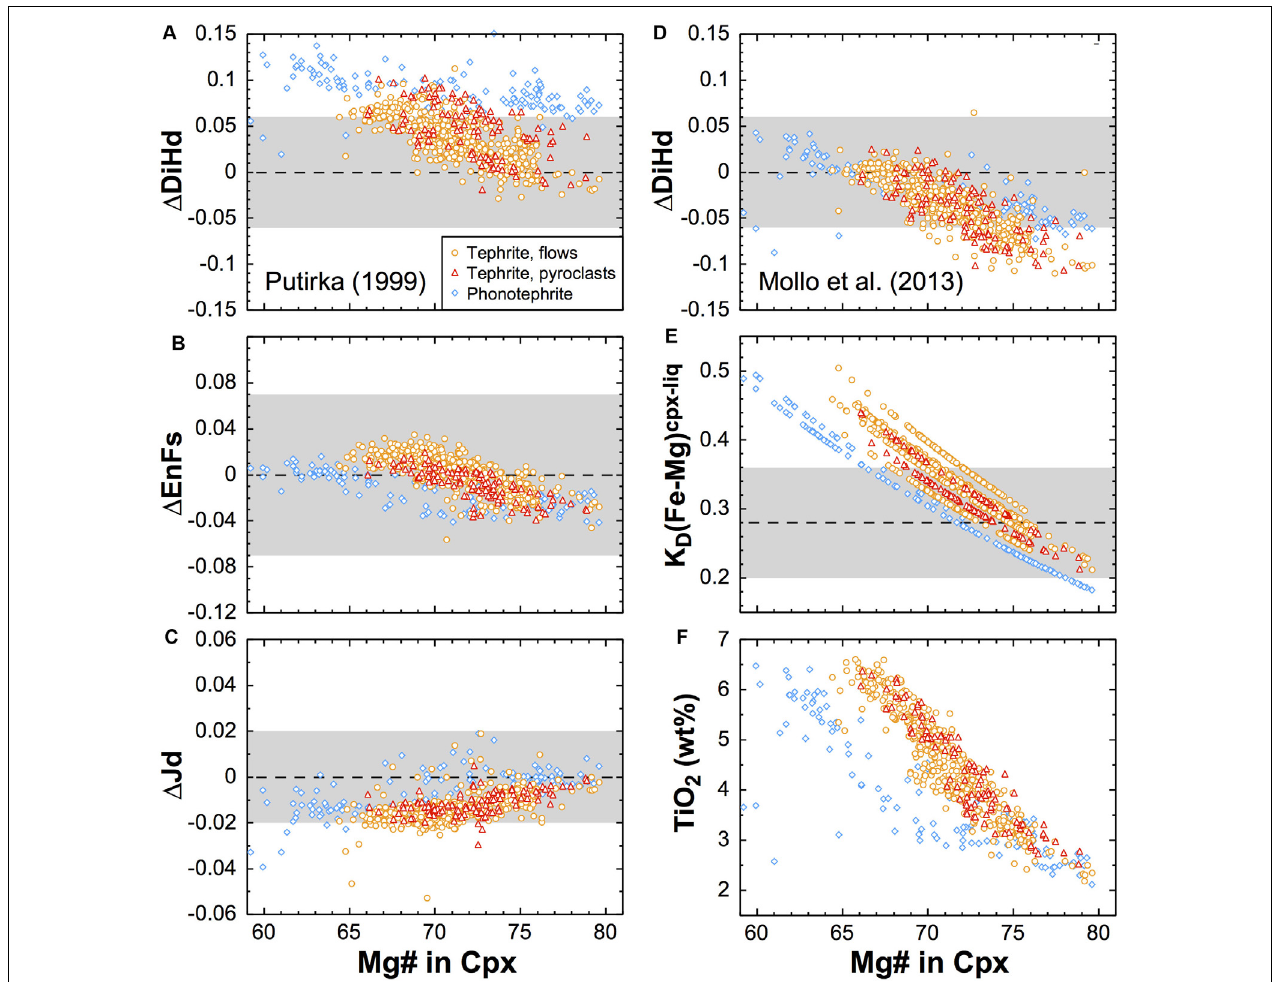
FIGURE 9 | Compositional range and equilibrium criteria for the rims of clinopyroxene phenocrysts in tephrites (590 analyses) and phonotephrites (diamonds; 125 analyses) from the 2014–2015 eruption. The diagrams present clinopyroxene Mg# versus (A) (cid:49) DiHd; (B) (cid:49) EnFs; (C) (cid:49) Jd; (D) (cid:49) DiHd after Mollo et al. (2013); (E) measured K D (Fe-Mg) cpx − liq using groundmass compositions; and (F) TiO 2 in clinopyroxene. In (A–C) the delta notations indicate the difference between predicted and measured clinopyroxene components after Putirka (1999). For (cid:49) EnFs, the more recent calibration of Mollo et al. (2013) yields a similar distribution but is shifted by +0.010 to +0.015. Dashed lines show the equilibrium values for clinopyroxene components and the global mean for K D (Fe-Mg) cpx − liq ; gray fields encompass ± 1 SEE of the model error for clinopyroxene components, and ± 1 standard deviation for the mean K D (Fe-Mg) cpx − liq (Putirka, 2008). For tephrites the diagrams discriminate between crystals in rapidly cooled pyroclasts (samples SD04 and SD06; triangles) and slowly cooled lava flows (circles), showing that there is no significant difference between both